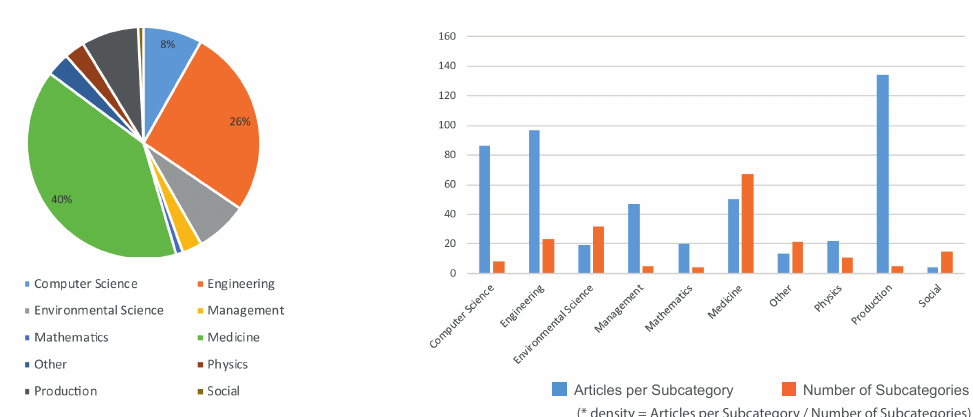
Figure 6. Section Distribution and Article Density (Improved